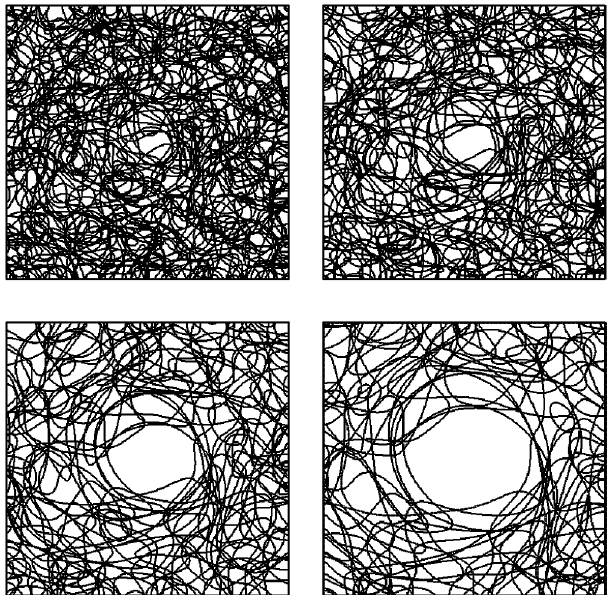
FIG. 18. Isogloss evolution in a 400 × 400 system with V ¼ 2 , β ¼ 1 . 1 , σ ¼ 5 at t ¼ 10 , 15, 25, 35 with ρ ¼ e − r=R , where R ¼ 20 and r ¼ 0 corresponds to the center of the system. Plot is a superposition of 20 simulations with different initial conditions. Central peak repels isoglosses. See video in Supplemental Material for full animation